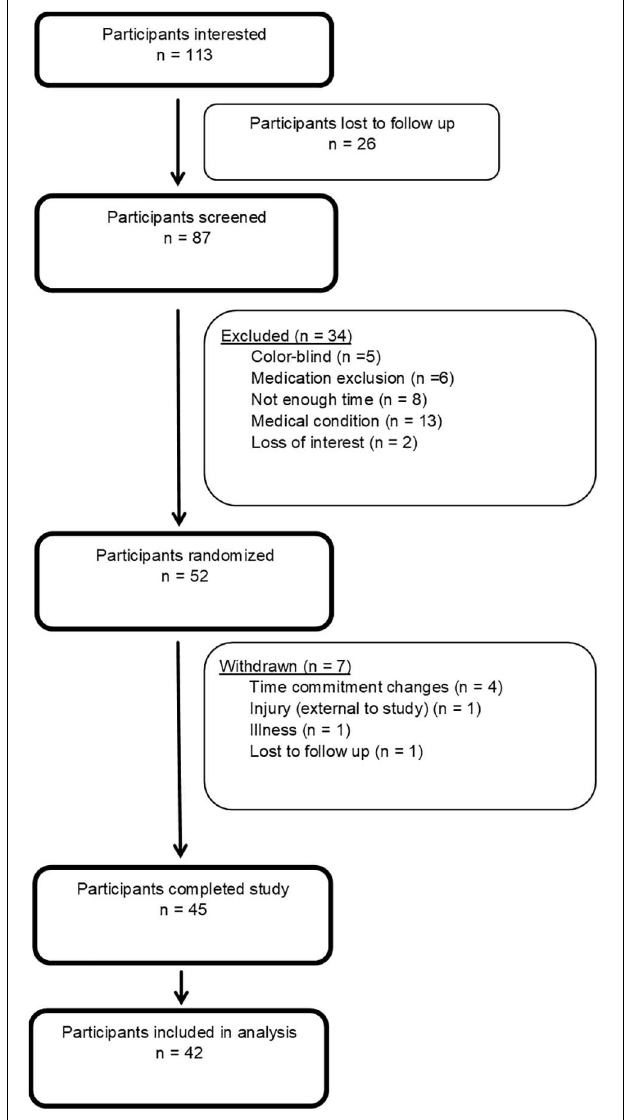
FIGURE 1 | Flow of participants through